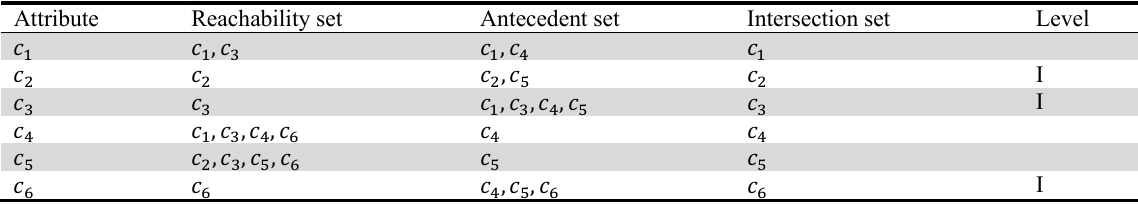
First iteration of partition analysis